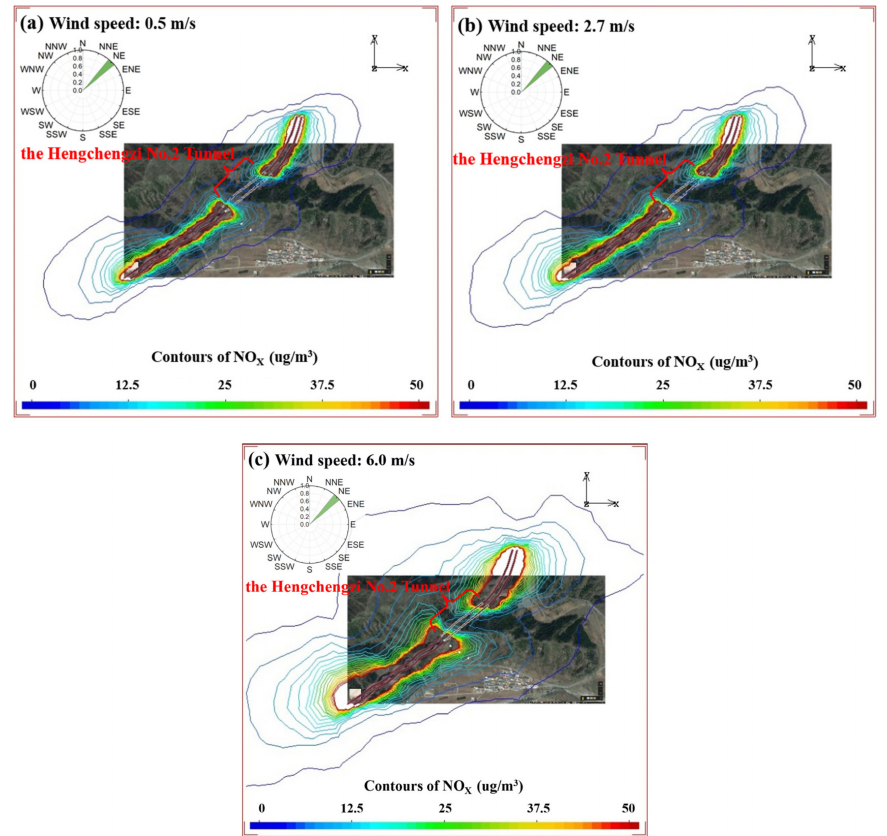
Figure 13. Concentration distribution of NO X under different wind speeds in the Hengchengzi No. 2 Tunnel section. ( a ) Low wind speed (0.5 m/s); ( b ) Medium wind speed (2.7 m/s); ( c ) High wind speed (6.0